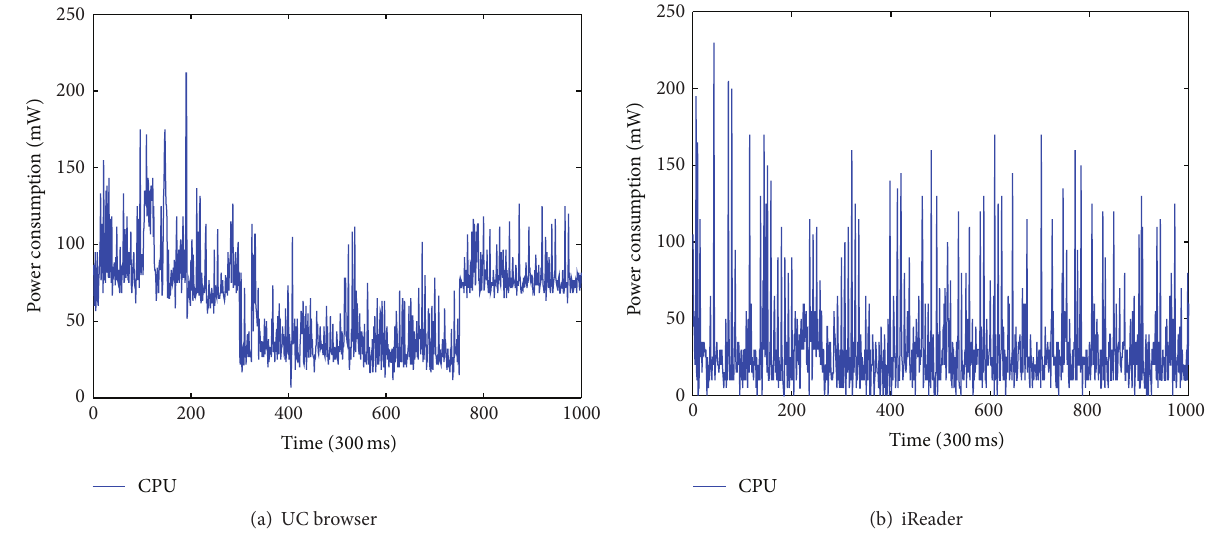
Figure 2: Application of battery consumption sequence diagram.